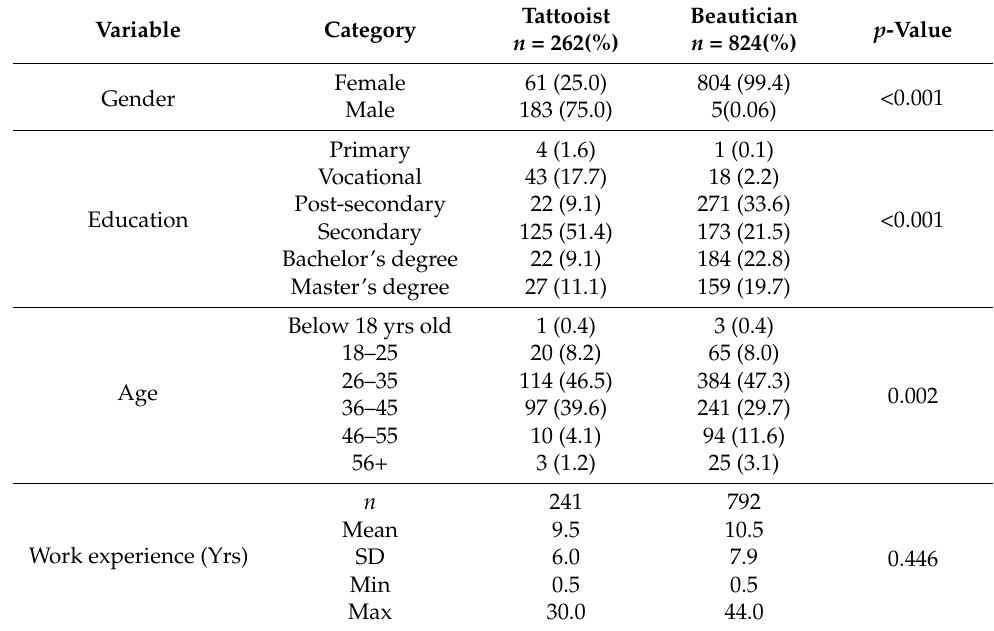
Table 1. Demographic characteristics of respondents ( n =